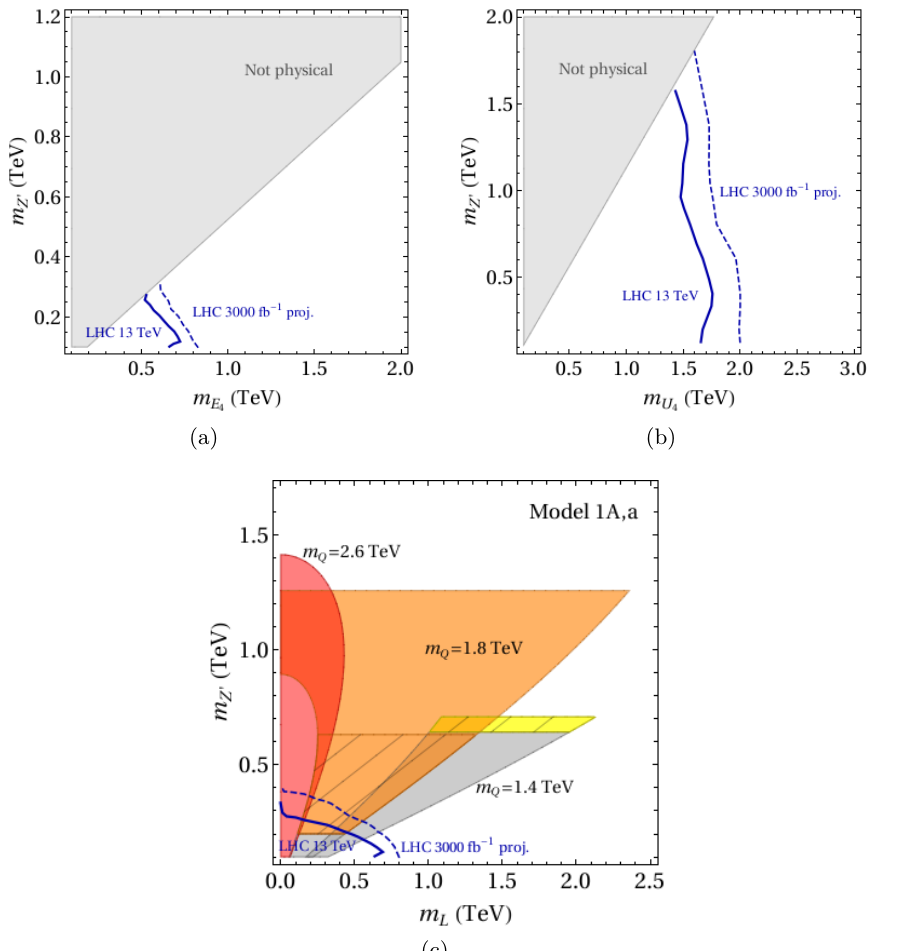
Figure 5 . (a) 95% C.L. lower exclusion bound on the mass of heavy VL leptons E 4 and N 4 from the CMS 13 TeV search [120] (solid blue line) and the projection for the future luminosity of 3000 fb − 1 (dashed blue line). (b) 95% C.L. lower exclusion bound on the mass of heavy VL quarks U and D 4 4 from the 13 TeV ATLAS searches [121] and [122] (solid blue line) and the corresponding projection (dashed blue line). (c) In the ( m ) plane, the parameter space of Model 1A , a allowed by L , m Z 0 the flavor anomalies and the constraints from B -meson mixing and neutrino trident production. s The present 95% C.L. exclusion bound on the VL quark mass is denoted in solid gray, while the corresponding projection for 3000 fb − 1 with dashed shadings. The 95% C.L. exclusion bound on the VL lepton mass and corresponding projection are indicated by a solid blue line and a dashed blue line,